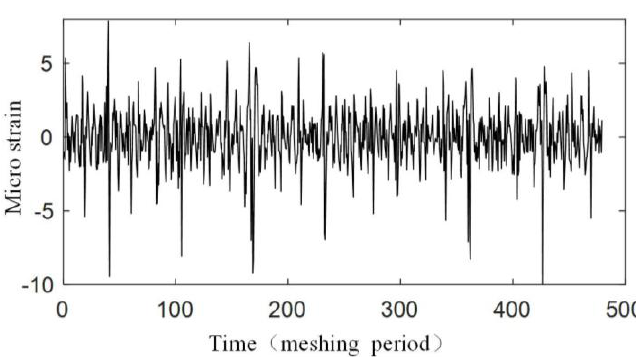
Figure 24. Strain signal measured by FBG1 under a tooth crack.